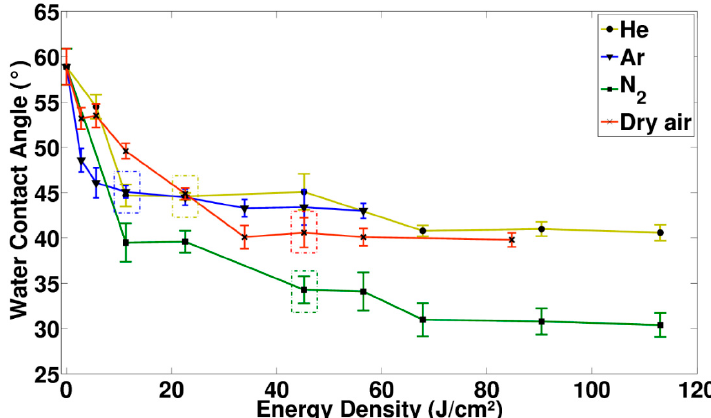
Figure 1. Results of water contact angle goniometry as a function of energy density. The optimized conditions used for further experiments have been marked with a box in their respective color.